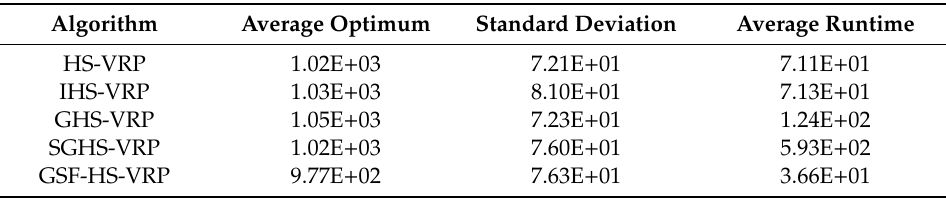
Table 6. Comparison results of fixed iteration times.